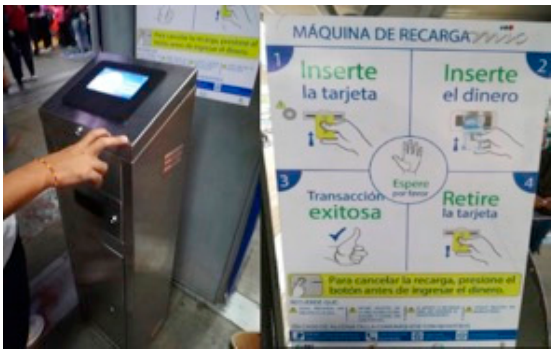
Figure 27. Interface of Mio top-up terminal for public transport in Cali. Instructions manually fixed to hardware with masking tape.